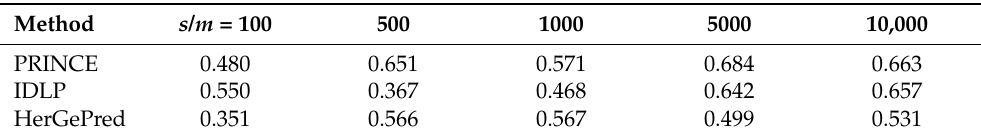
Table 9. AUC results evaluated by prediction scores for disease-gene association prediction without known disease genes from sample-2.